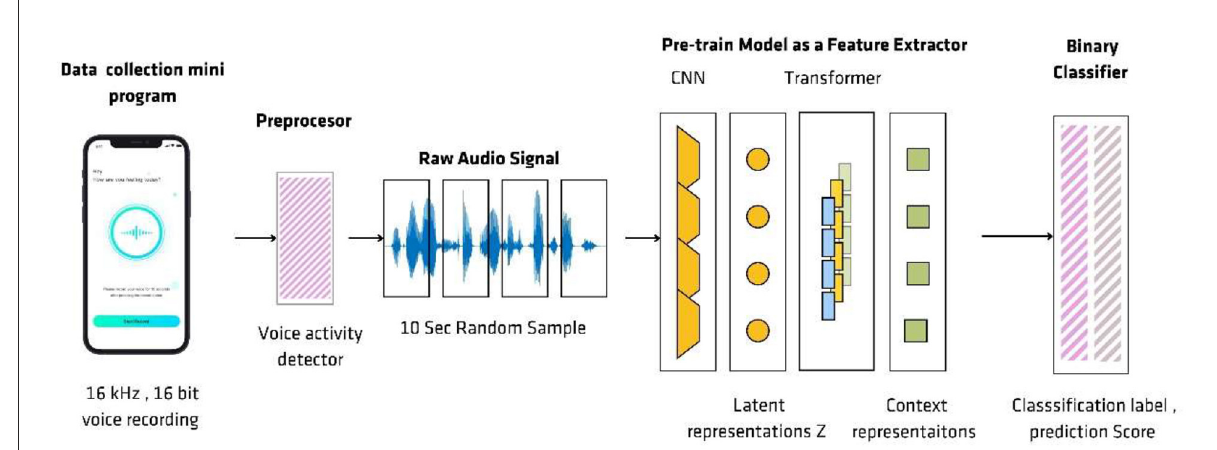
FIGURE1 The flow of voice processing. Audio and other metadata are collected via a We-chat mini program and pre-processed by voice activity detector to remove silence in the leading and training end of the voice clip. A 10s random sample is extracted from a preprocessed audio clip and later fed into a pre-trained model to extract